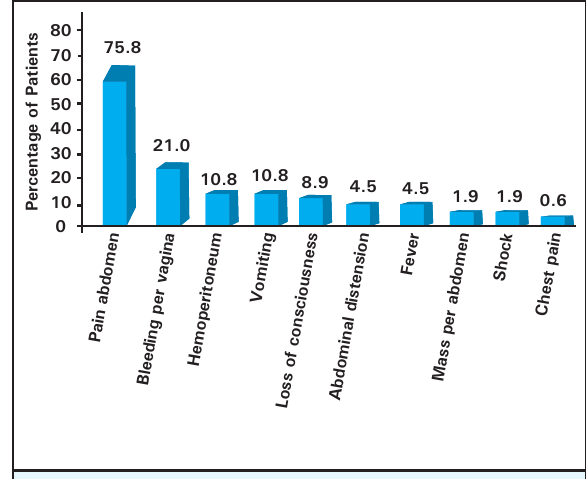
Figure 1. Distribution of participants as per age